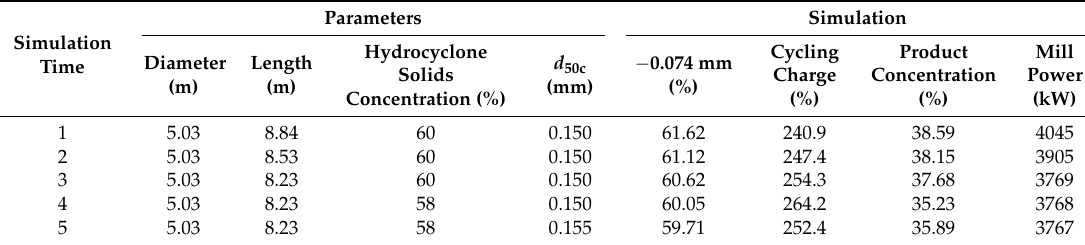
Table 7. The simulation process for ball mill